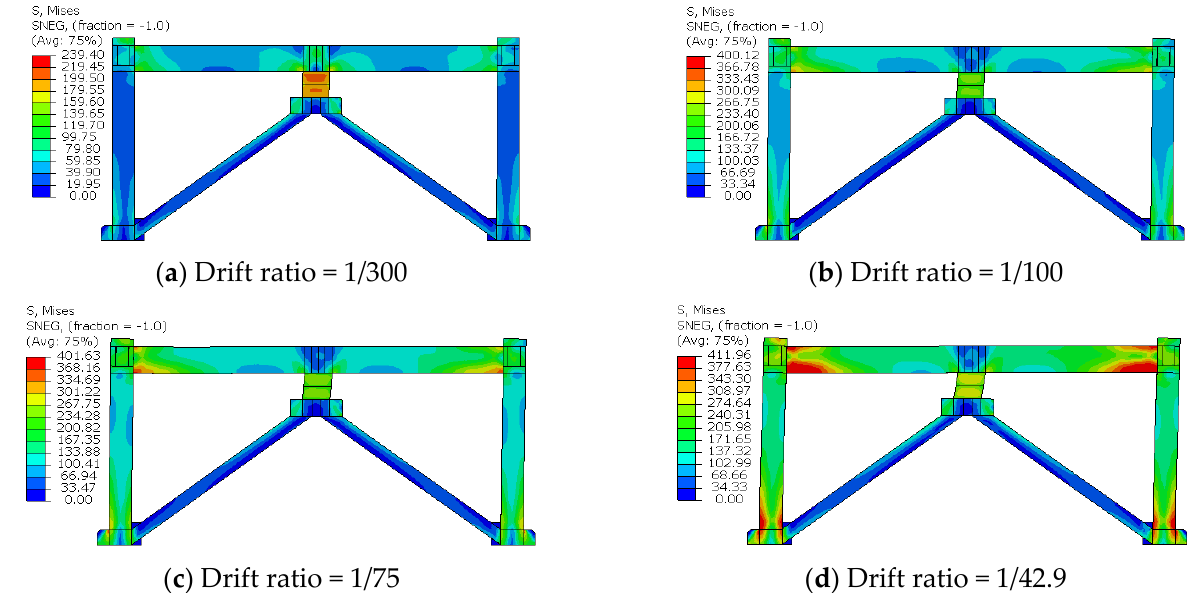
Figure 9. Stress cloud of the steel frame of specimen 2.